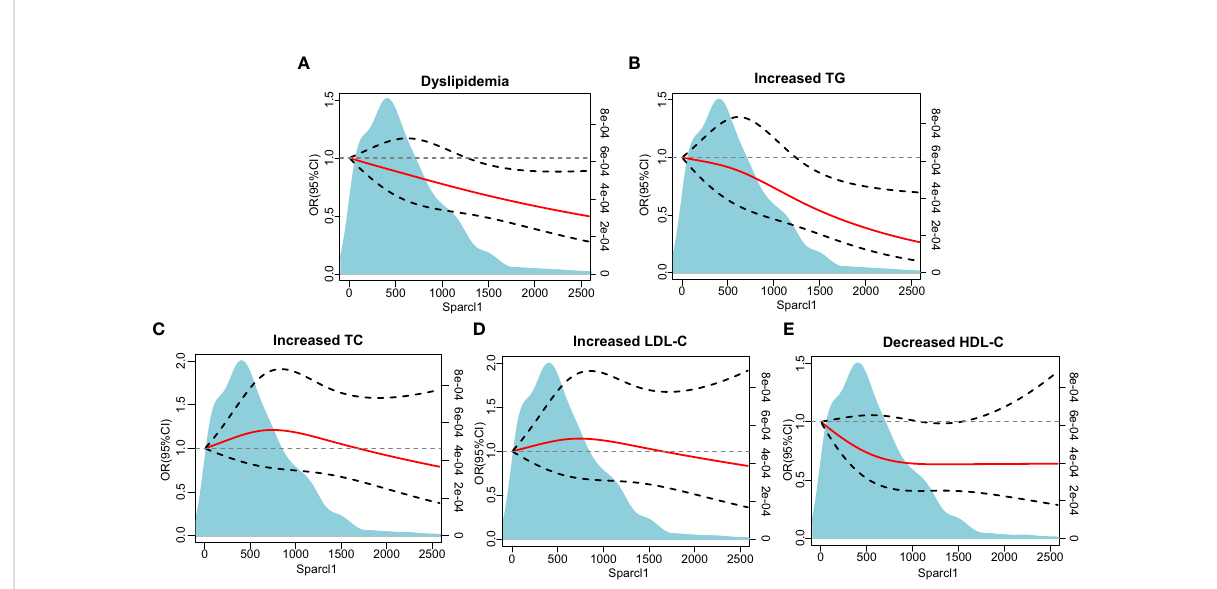
FIGURE 2 The association between serum Sparcl1 with dyslipidemia and individual components based on restricted cubic spines. (A) Dyslipidemia; (B) Increased TG; (C) Increased TC; (D) Increased LDL-C, (E) Decreased HDL-C. The red solid line represents a fi tted relationship and black dashed lines show 95% con fi dence intervals. Reference line for no association (odds ratio =1.0) is indicated by grey dotted line. Area of blue represents the density distribution of serum Sparcl1. Model was adjusted for age, sex, education of high-school or above, smoking and drinking status, physically active, and body mass index. TG, triglyceride; TC, total cholesterol; LDL-C, low-density lipoprotein cholesterol; HDL-C, high- density lipoprotein